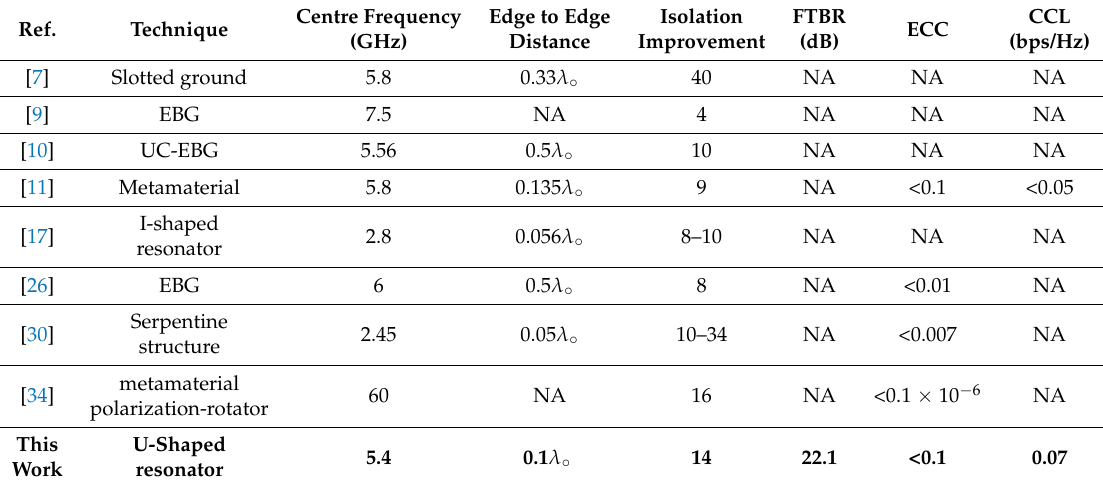
Table 1. Comparison table (where λ ◦ is the wavelength at centre